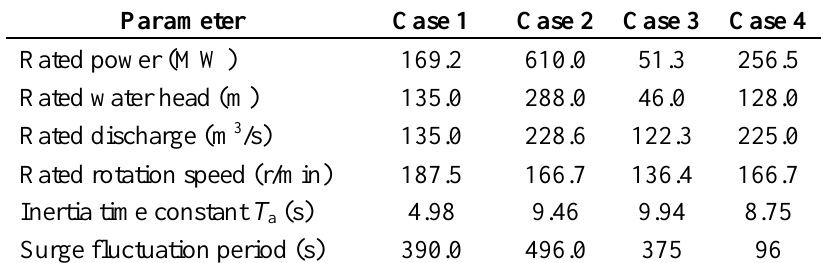
Table A1. Basic information of the engineering cases. Rated values and inertia time constants are for single